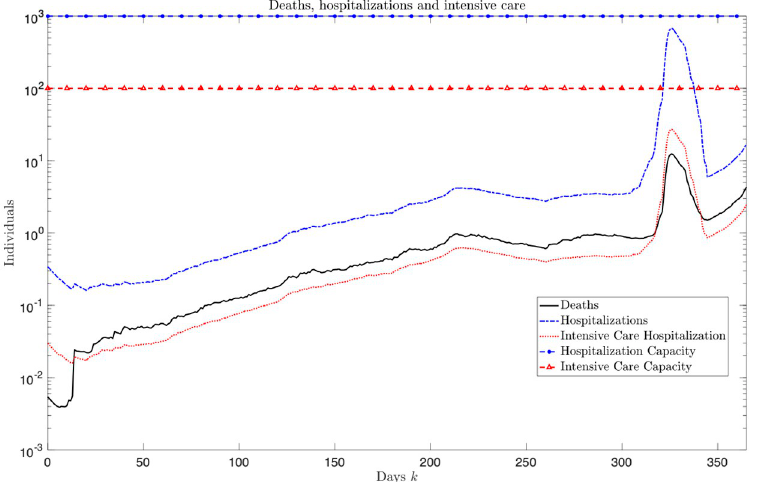
Fig 9. Deaths, hospitalizations and intensive care occupancies corresponding to the found solutions, plotted for each